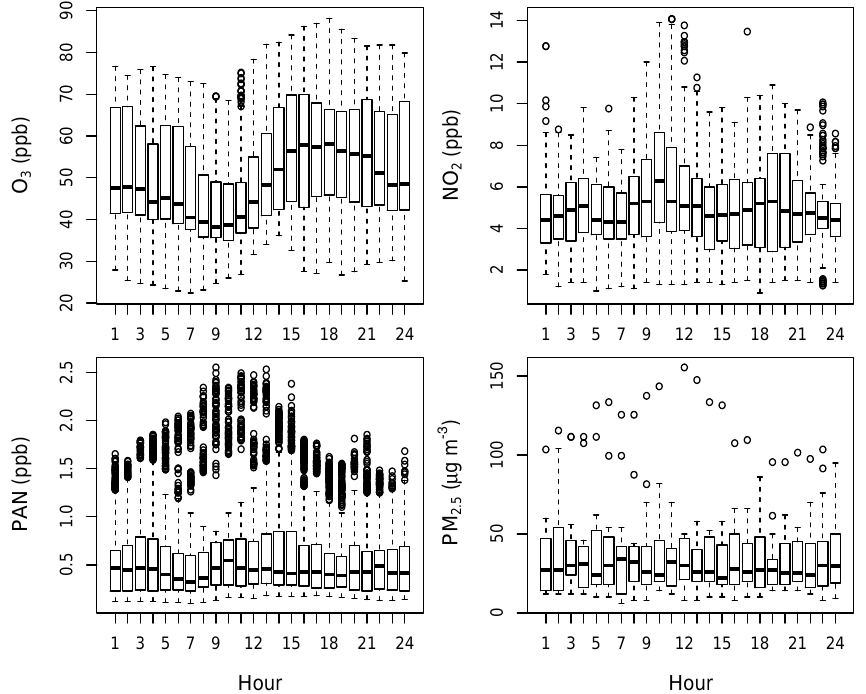
Figure 2. Diurnal variations in the concentrations of O 3 , NO 2 , PAN, and PM 2 . 5 , measured at GCO in the fall of 2010 (5min data of O 3 , NO 2 ; 2min data of PAN; 1h data of PM 2 . 5 )